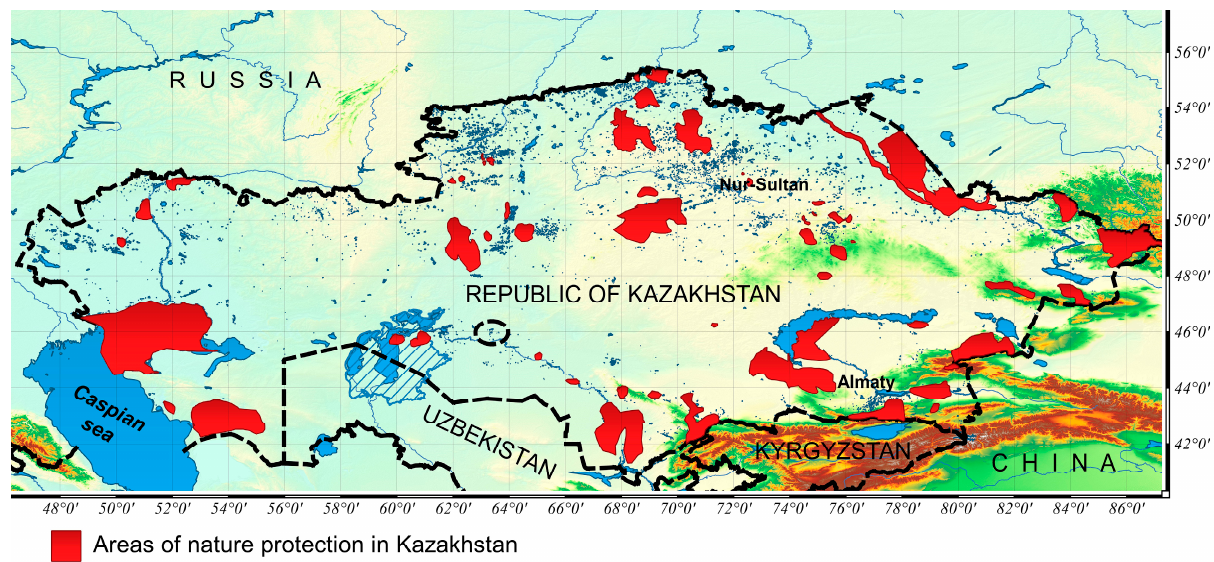
Figure 14. Map of protected areas in Kazakhstan.